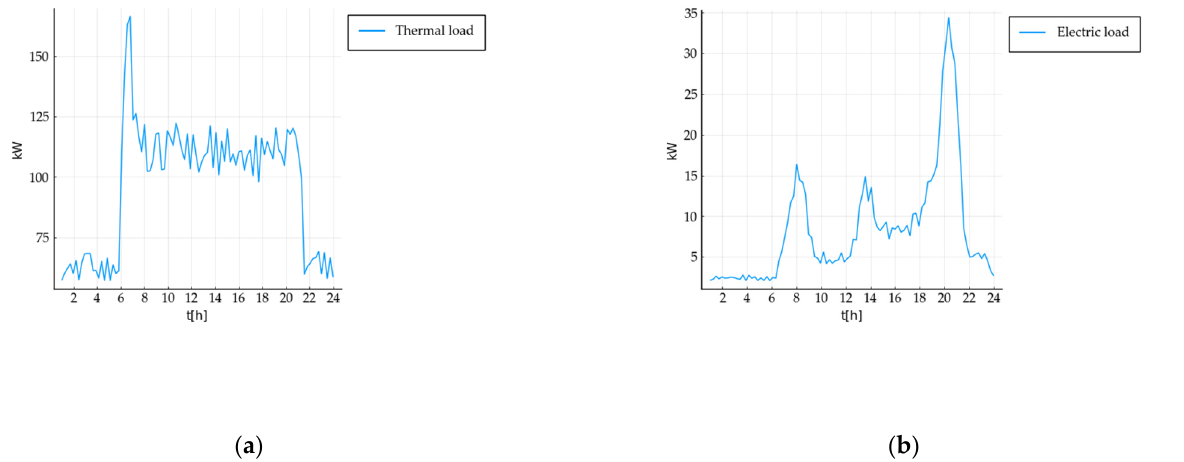
Figure 5. Daily evolution of the dwelling consumptions for a typical cold winter day: ( a ) electricity consumption; ( b ) thermal consumption.